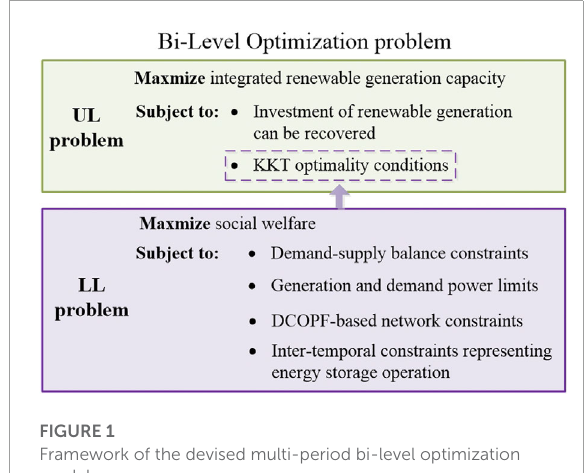
FIGURE 1 Framework of the devised multi-period bi-level optimization